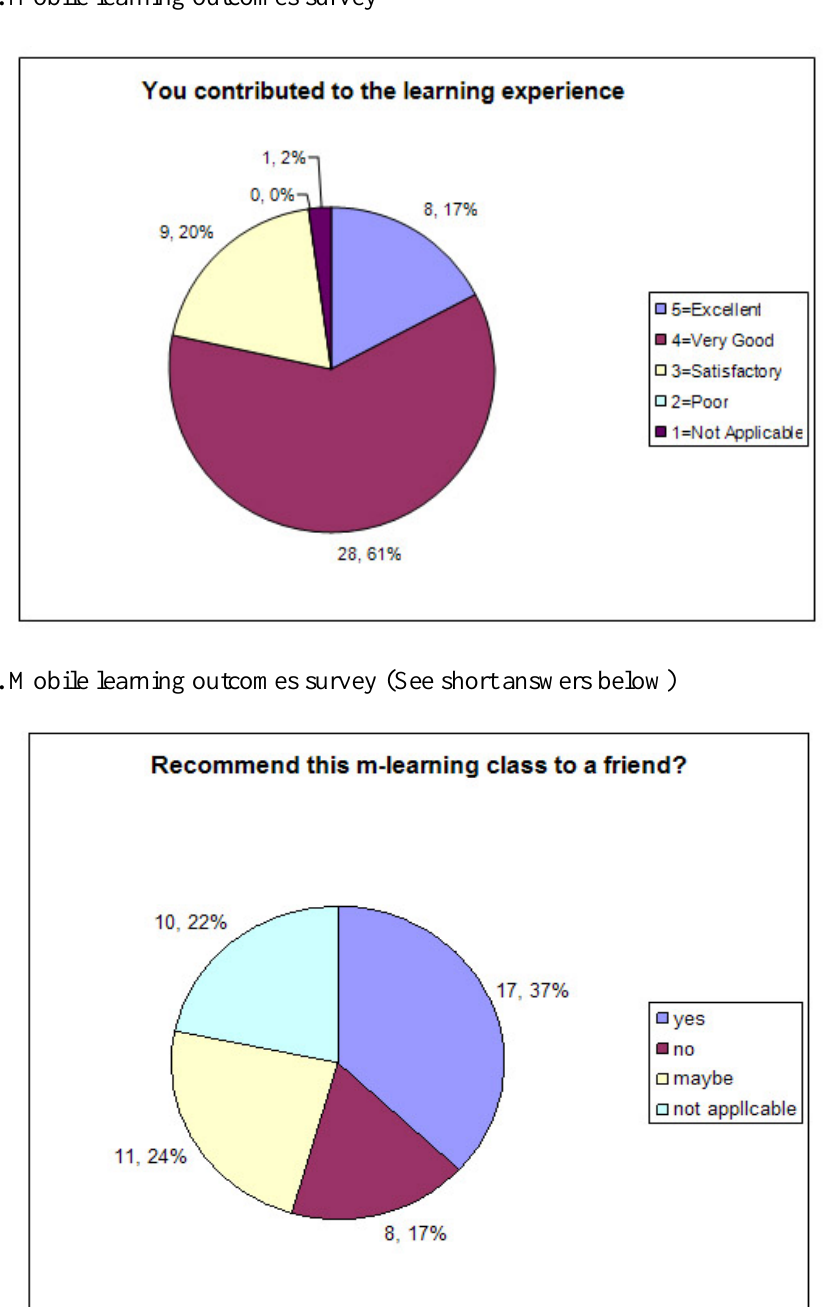
Figure 11. Mobile learning outcomes survey